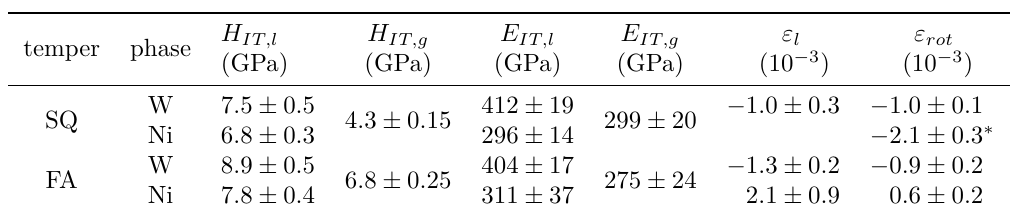
Table 3. Local properties of W particles and Ni matrix of two investigated material tempers: instrumented nanohardness H IT , indentation modulus E IT , longitudinal and isotropic residual strains ε l , ε rot in W particles and Ni rich matrix. * indicates possible measurement artifact.